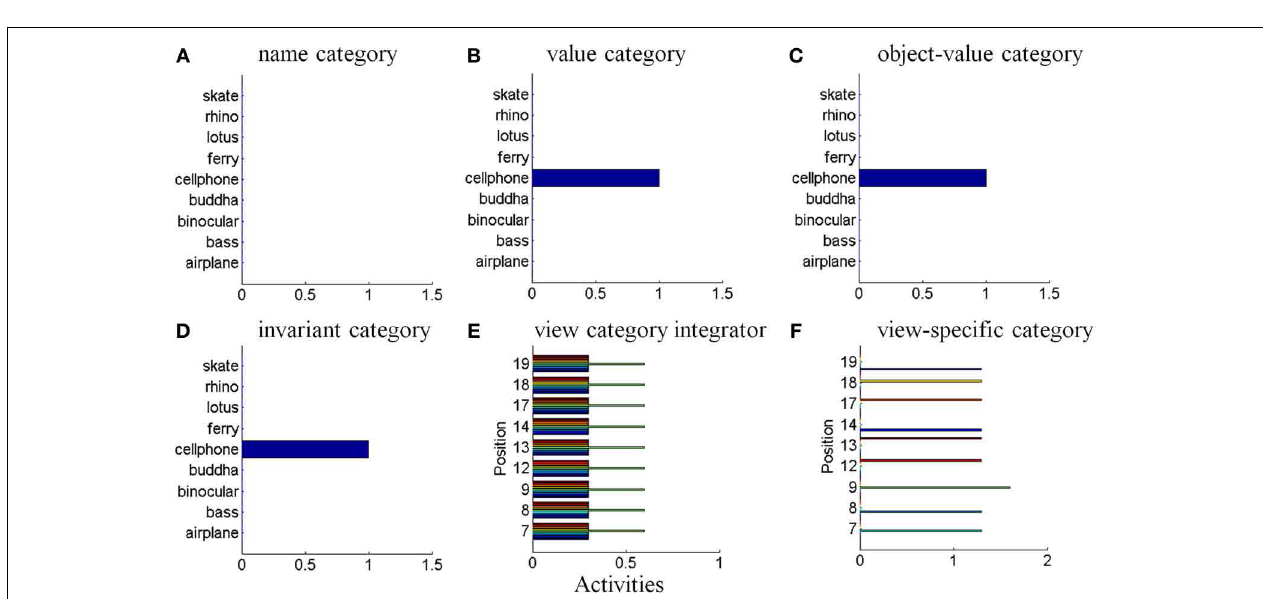
FIGURE 14 | Where’s Waldo motivational drive search results. The category representations during a motivational drive search are consistent with the interactions in Figures 6C,D . The value category that was associated with the cellphone receives an internal motivational priming